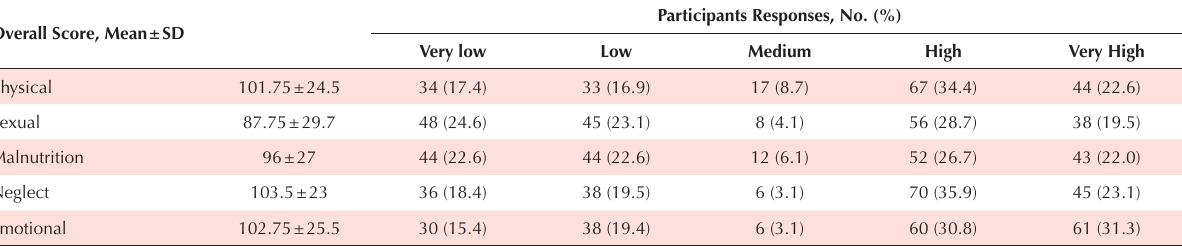
Table 2. Different domains of child abuse Overall Score, Mean ± SD